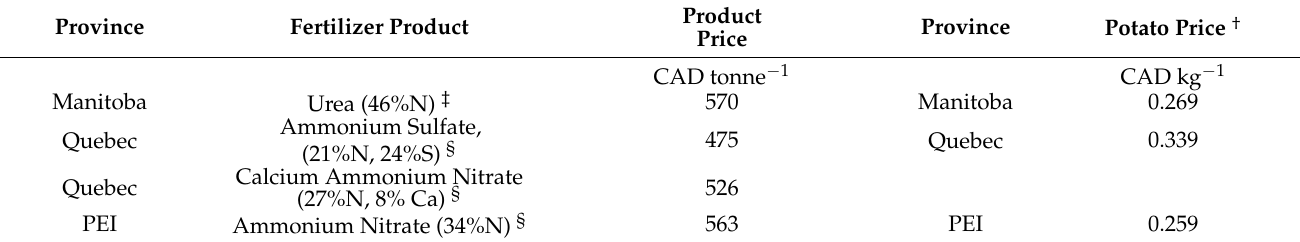
Table 4. Fertilizer and potato prices in Manitoba, Quebec, and